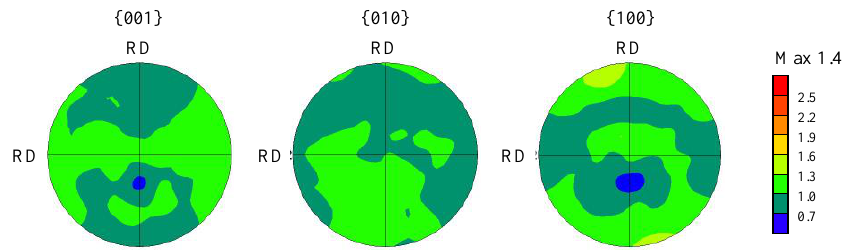
Figure 3. {001}, {010}, and {100} pole figures of as-sintered samples obtained by the EBSD.